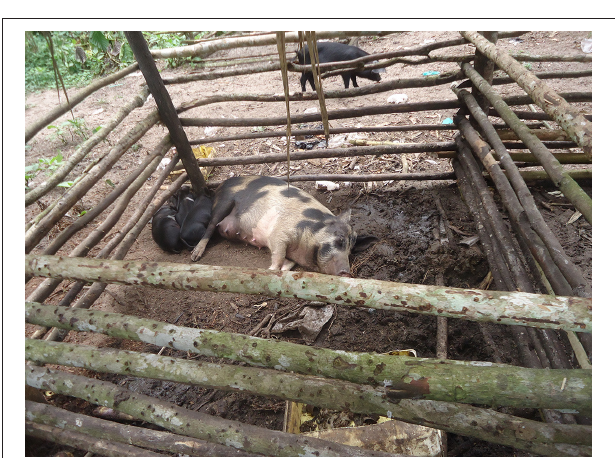
FIGURE 3 | Housed sow with piglets in Uganda (picture credit: Michel Dione, ILRI).